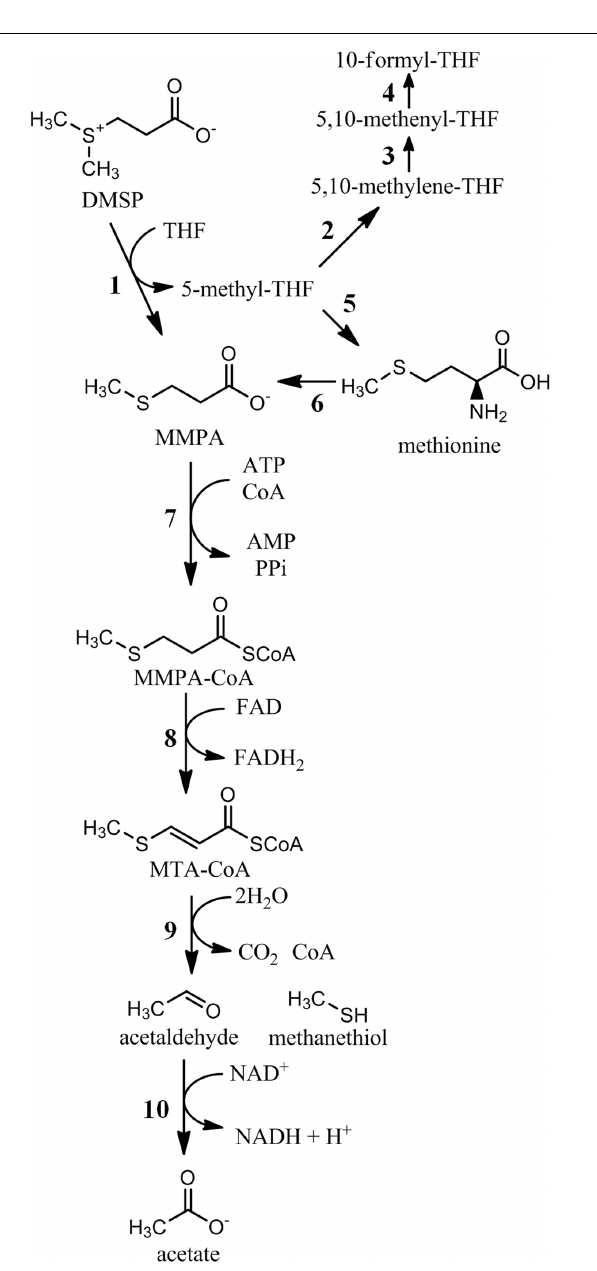
FIGURE 2 | Biochemical pathways of DMSP demethylation. 1, DMSP demethylase (DmdA); 2, 5,10-methylene-THF reductase (MetF, E.C. 1.5.1.20); 3, methylene-THF dehydrogenase (FolD, E.C. 1.5.1.5); 4, methenyl-THF-cyclohydrolase (E.C. 3.5.4.9); 5, methionine synthase